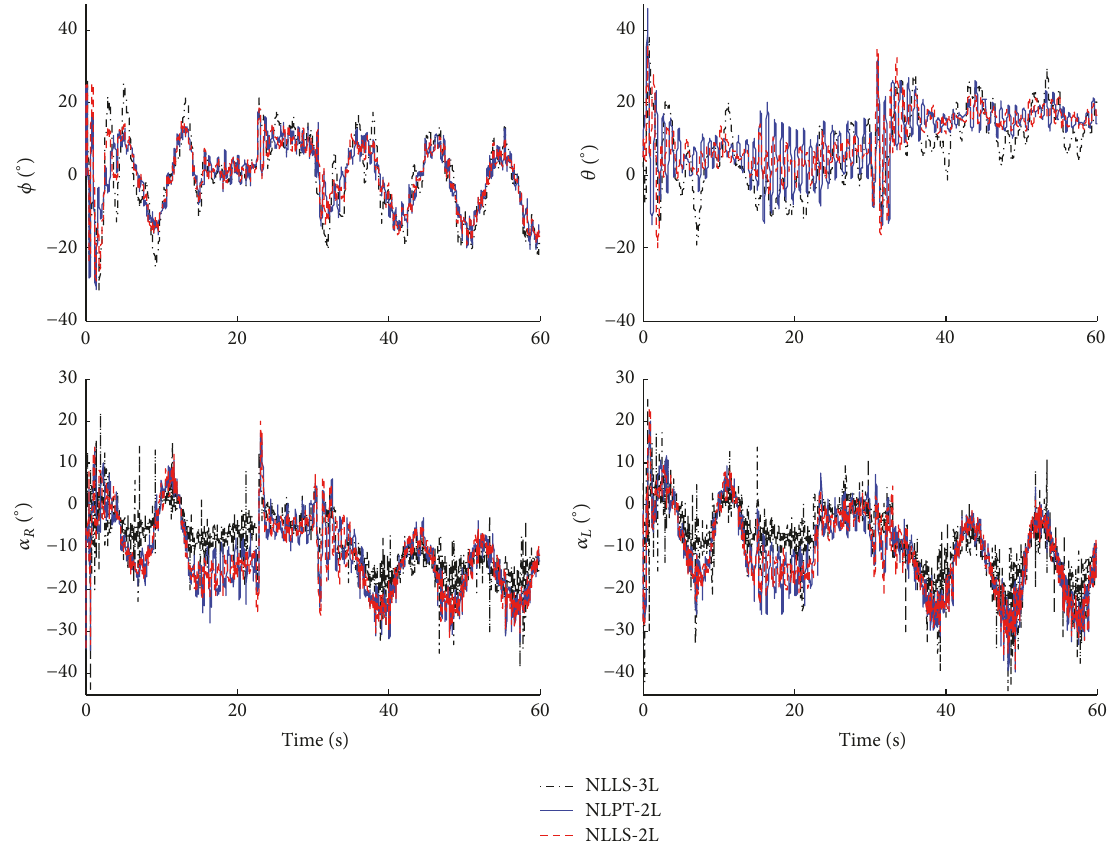
Figure 8: Body and tiltable mechanism angles on NLPT-2L, NLLS-2L, and